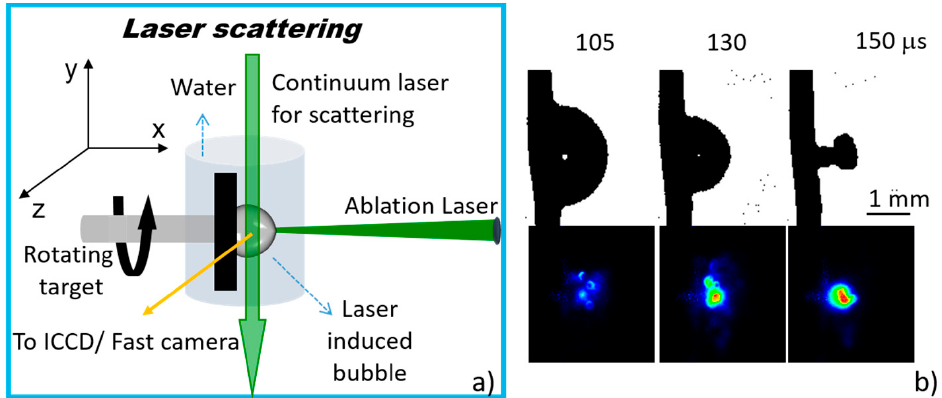
Figure 11. ( a ) Sketch of the experimental set-up for laser-scattering technique, ( b ) upper: temporal resolved shadowgraph images; lower: laser scattering images of laser-induced bubble on a Pt wire in water. (Laser pulse width = 6 ns, laser wavelength = 532 nm, laser frequency = 10 Hz, fluence = 203 J cm − 2 , ICCD gate width = 20 µ s, 5 accumulations for each image) .